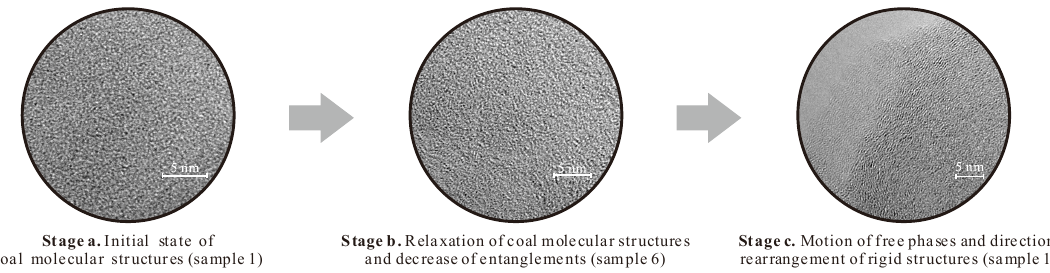
Figure 12. Evolution path of coal molecular structures during deformation experiments.